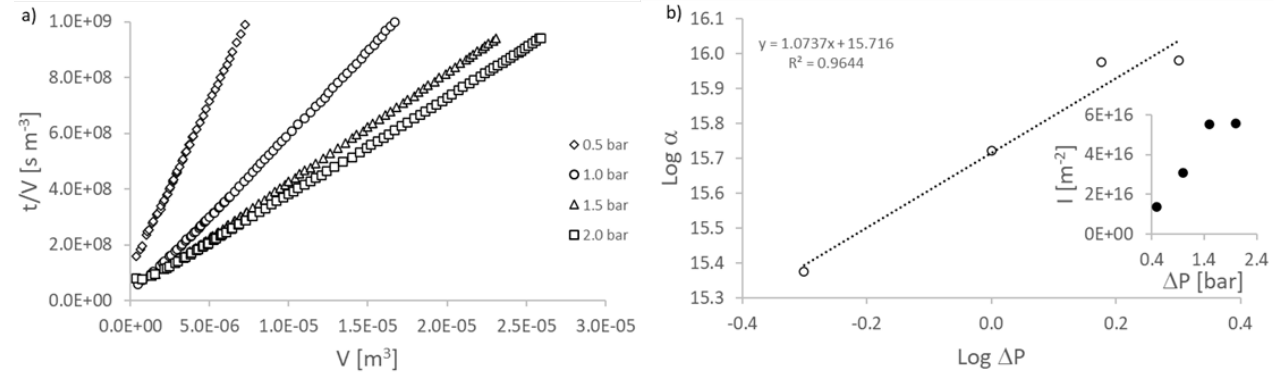
Figure 5. Manipulation of the frontal (dead-end) filtration experimental data from which to derive filtration characteristics. ( a ) Plot of t/V versus V from which to derive the membrane resistance and specific cake resistance; ( b ) log-log plot of specific cake resistance and applied pressure from which to derive the compressibility index (inset shows values of fouling index (I) versus applied pressure).